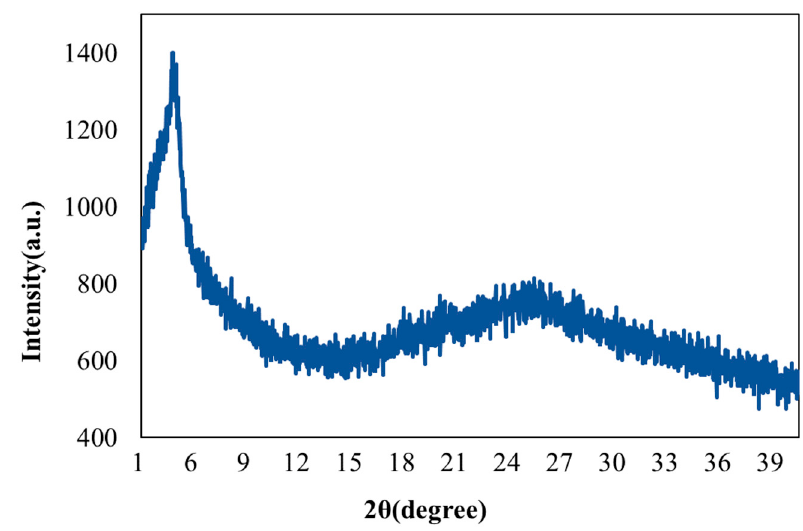
Figure 6. X-ray diffraction pattern of the rGO/DPP2T-TT film.